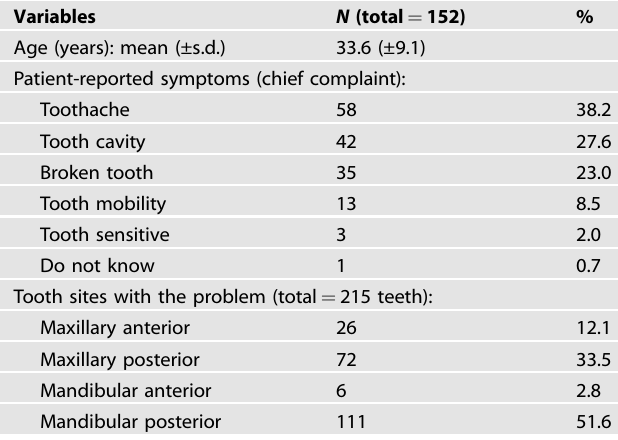
Table 1. Characteristics of the